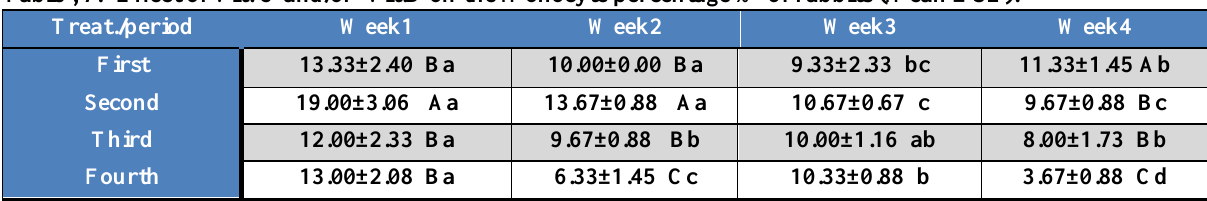
Table , 7: Effect of Vit. C and/or Vit.B on the Monocyte percentage % of rabbits (Mean ± SE). Treat./period